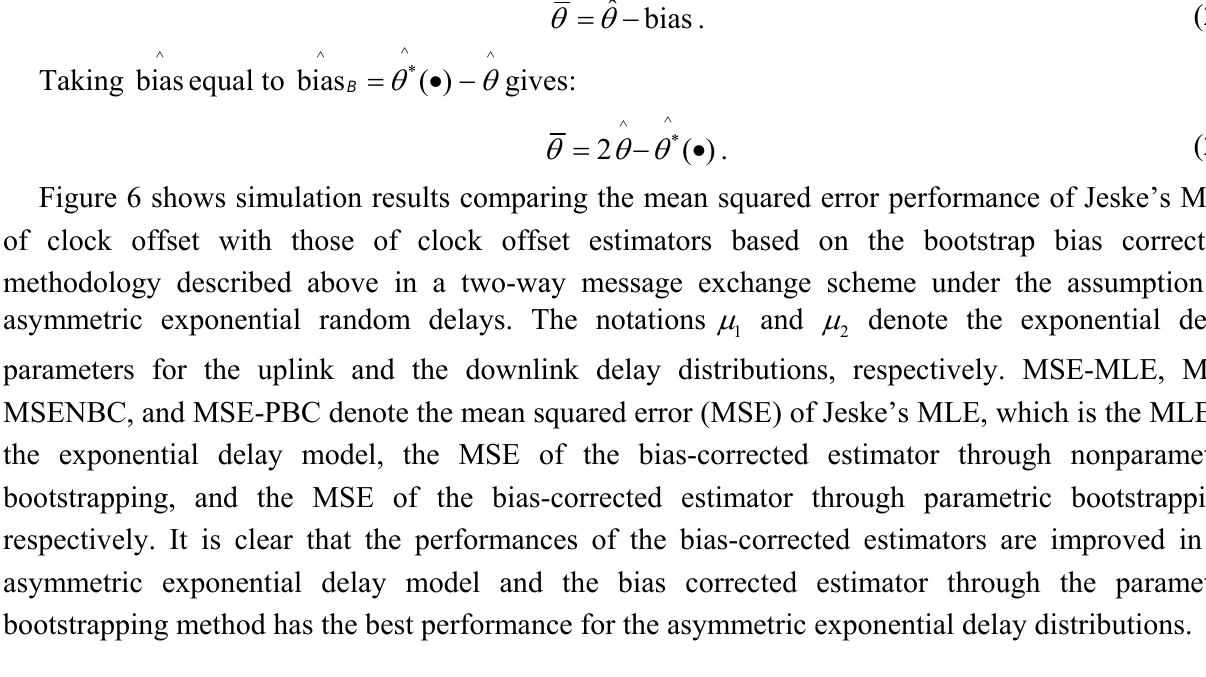
Figure 6. MSEs of clock offset estimators for asymmetric exponential delays (